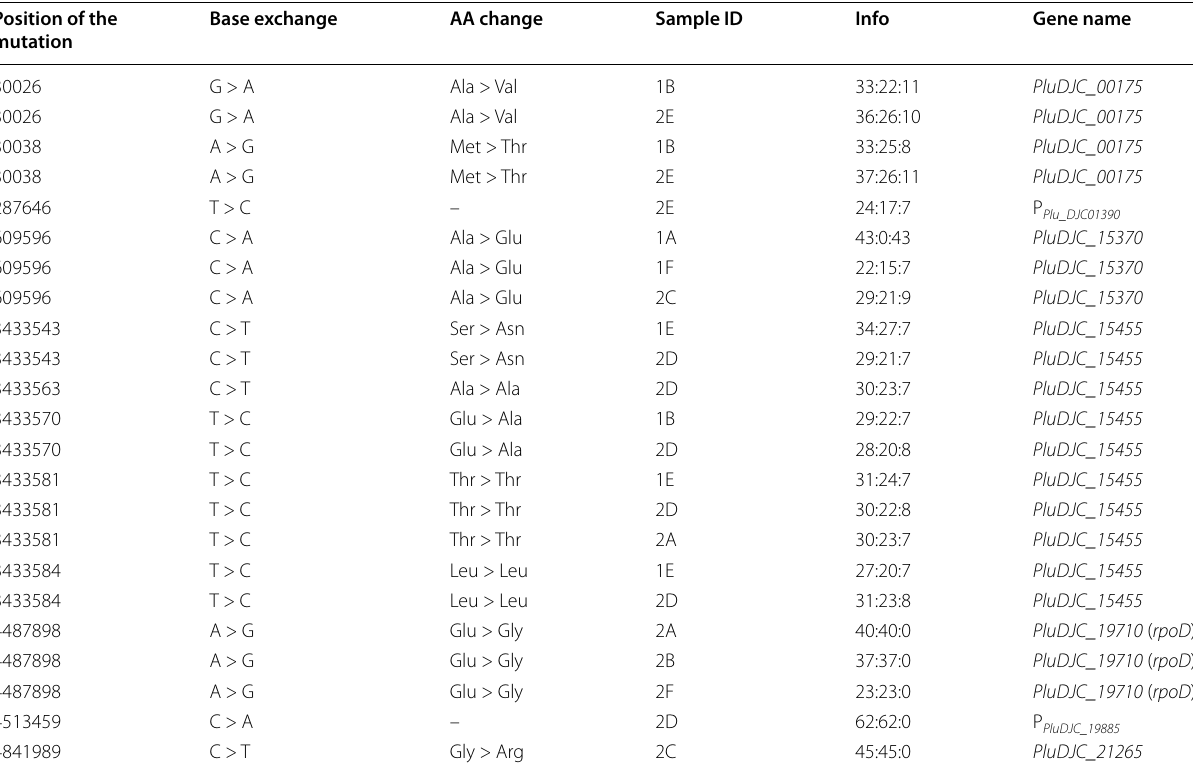
Table 1 Point mutations in different gene loci of P. luminescens 1° and 2° clones identified by HTS. Sample ID 1 indicates 1° cells and 2 indicates 2° cells of P. luminescens . A–F indicate the 6 different replicates of each tested phenotypic variant. The info indicates the sum of the coverage with the reference genome (n1), the number of matches with the covered region (n2), and the number of occurring SNPs within n1 (n3) represented as n1:n2:n3 Position of the